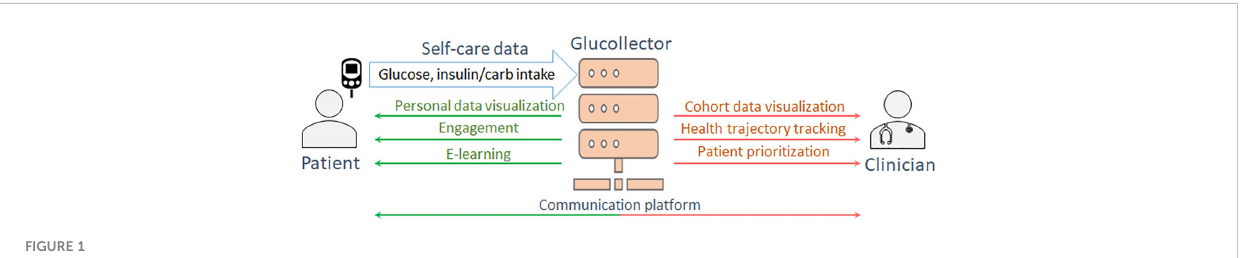
FIGURE 1 The functionality of